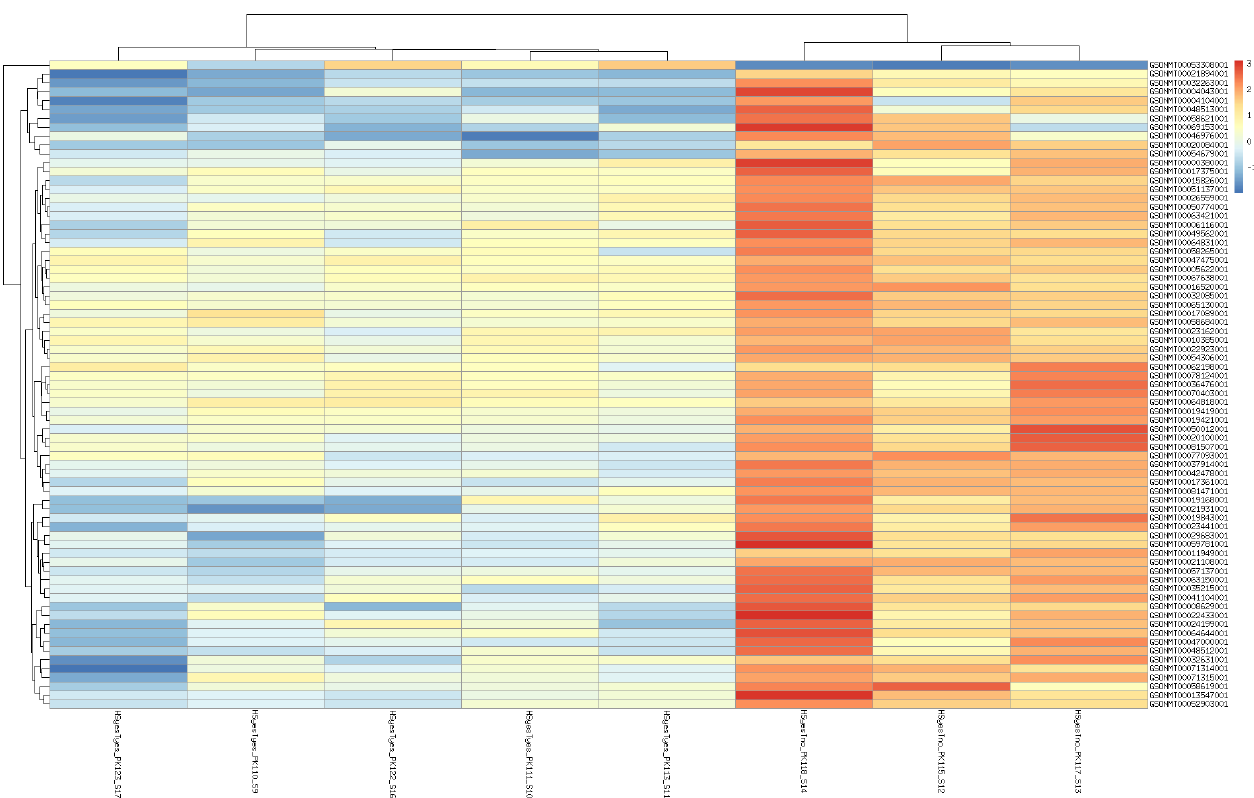
Figure 4. Heatmap of differentially expressed genes affected by taxifolin treatment under increased Figure 4. Heatmapofdifferentiallyexpressedgenesaffectedbytaxifolintreatmentunderincreasedtemperature. temperature. A general overview of the processes affected in either group is given by GO term enrichment results (Figures 5 and 6).